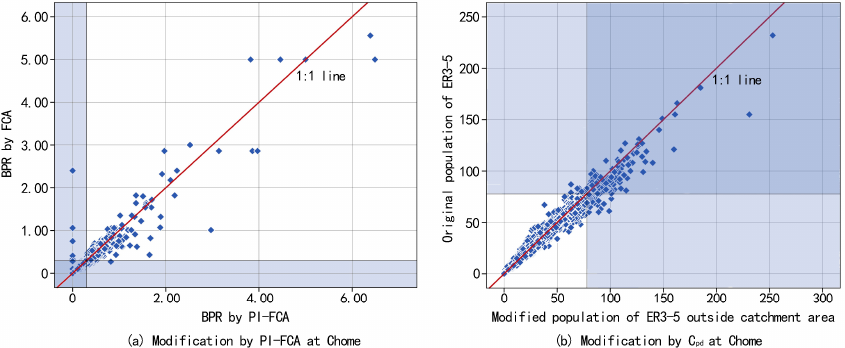
Figure 7. Comparative analysis to illustrate modification of the BPR by the PI-FCA ( a ), and modification of the population of the ER3-5 by C pd ( b